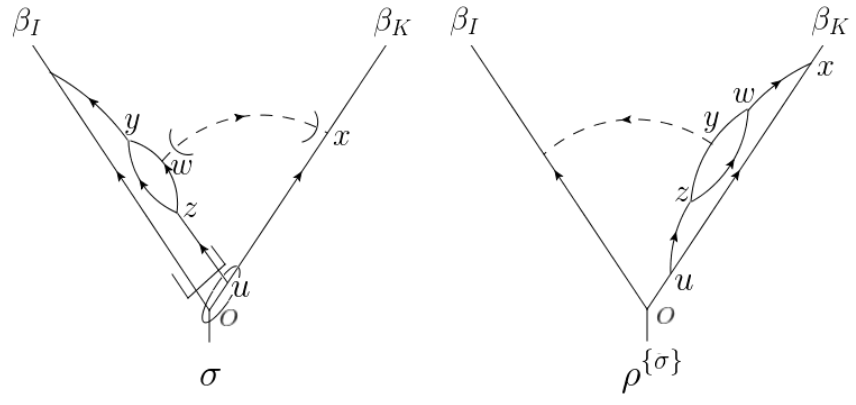
Figure 45. An example of the pinch surfaces (cid:27) (of A ) and (cid:26) f (cid:27) g (of t (cid:27) A ), where the vertices w (cid:22) , y (cid:22) and z (cid:22) are in alignment to (cid:12)